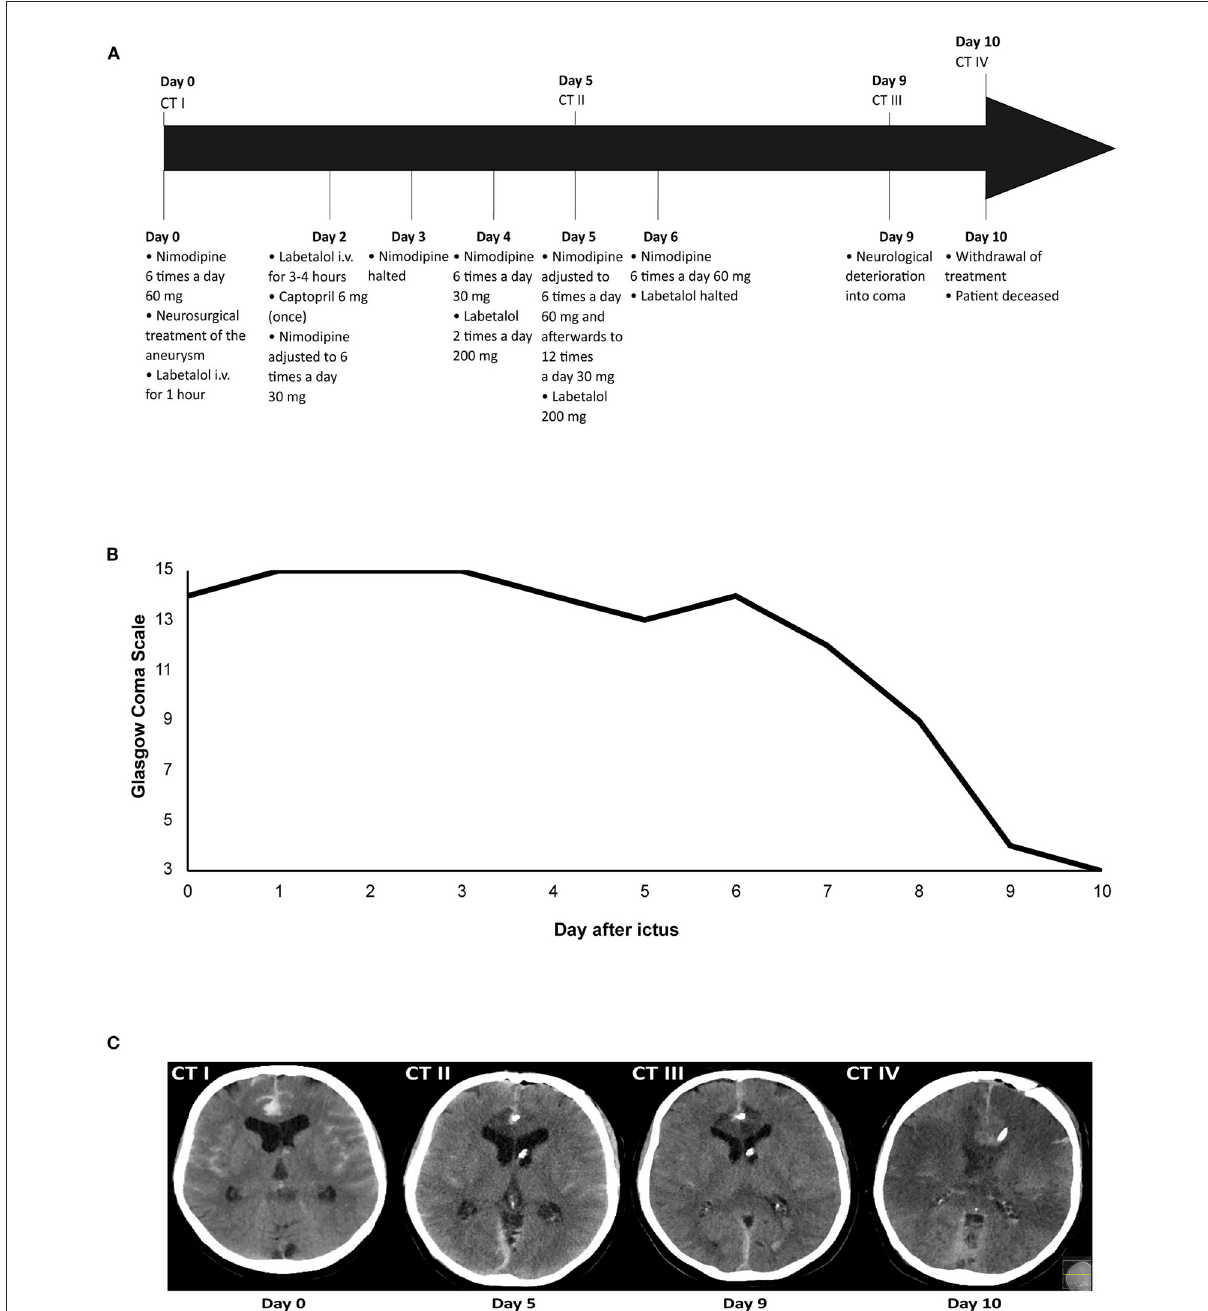
FIGURE1 Illustrative case of a patient with devastating DCI. Time overview of: (A) Blood pressure medication adjustments and computed tomography (CT) scans; (B) Glasgow Coma Scale score; and (C) Ischemic lesions due to delayed cerebral ischemia on CT. The patient was admitted on day 0